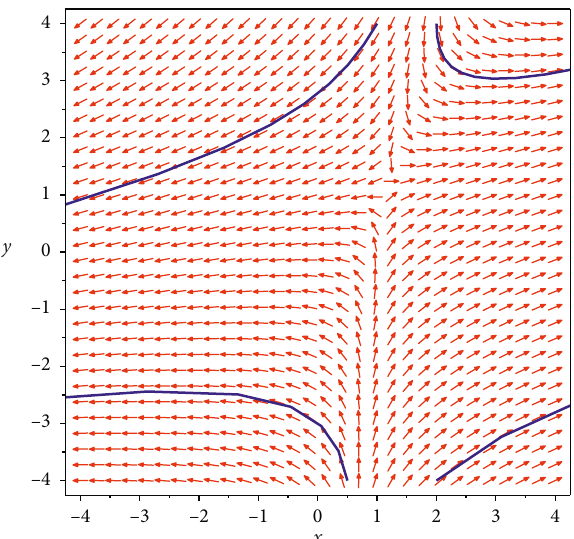
Figure 2: The vector fields of model (71) when u < Kr /4, here u � 2 ,K � 8, and r � 2.